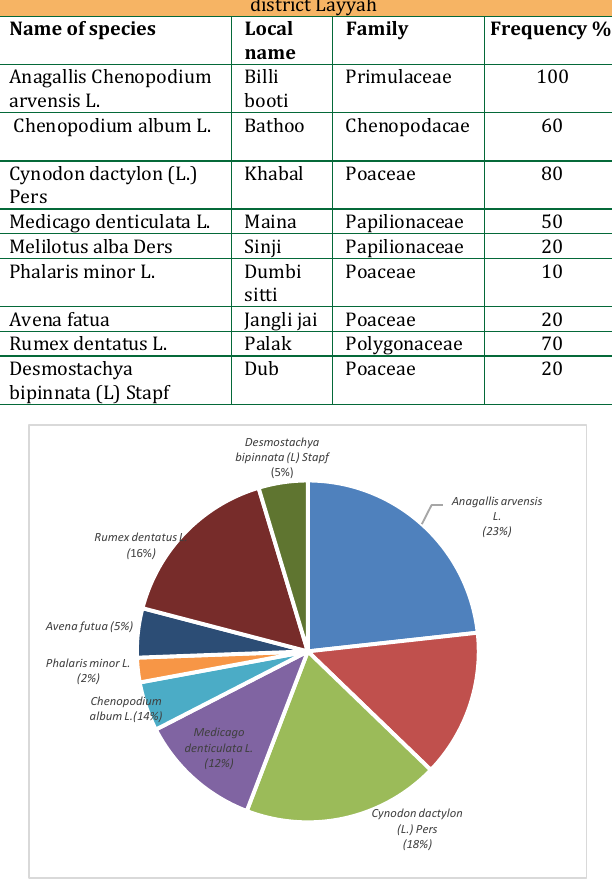
Table 1: Frequency (%) of weeds infesting wheat field at Nawan Kot district Layyah